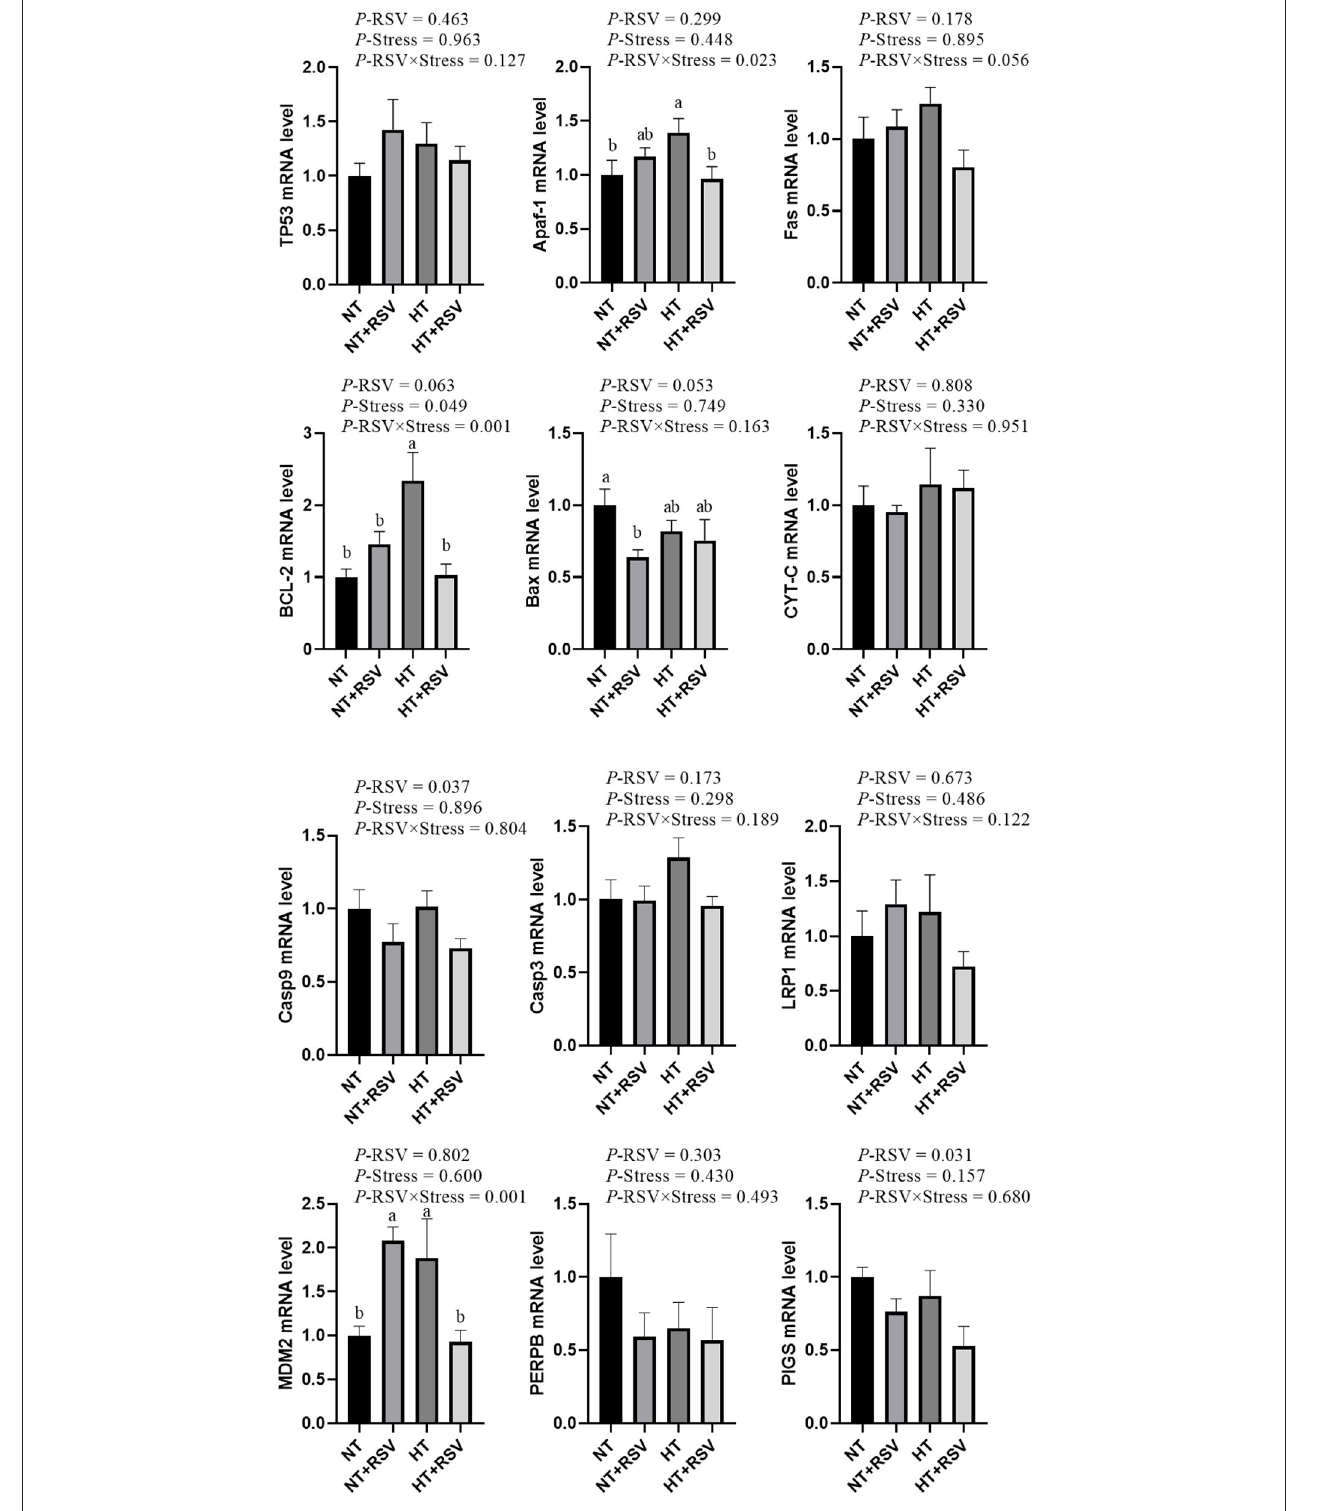
FIGURE 3 | Effect of heat stress and RSV on some related gene involved in apoptosis genes expression levels in spleen of 42-day-old broilers (d 14 of heat treatment). Bars represent the means ± SEM ( n = 6), bars with different letters are statistically significant in different treatments. P -values ( P -RSV, P -Stress, or P -RSV × Stress) ≤ 0.05 indicates RSV, heat stress, or the interaction between heat stress and RSV.